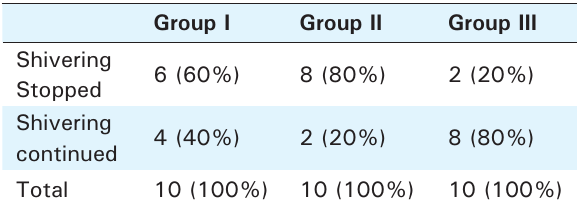
Table 5. Outcome of